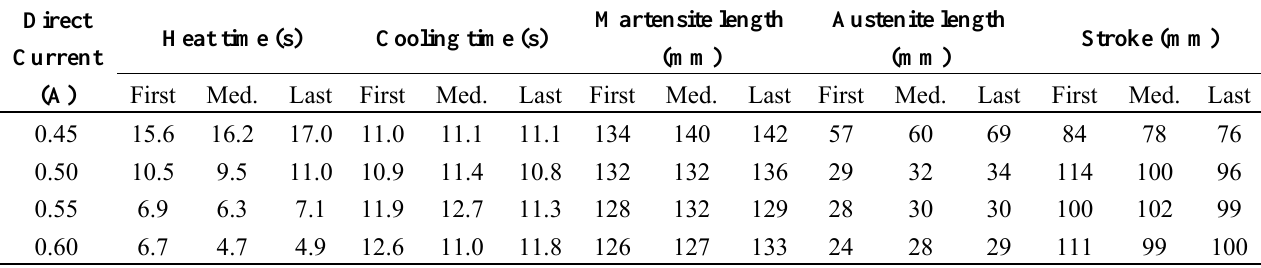
Table 8. The averaged first, median and last values for the direct current manipulation. Direct